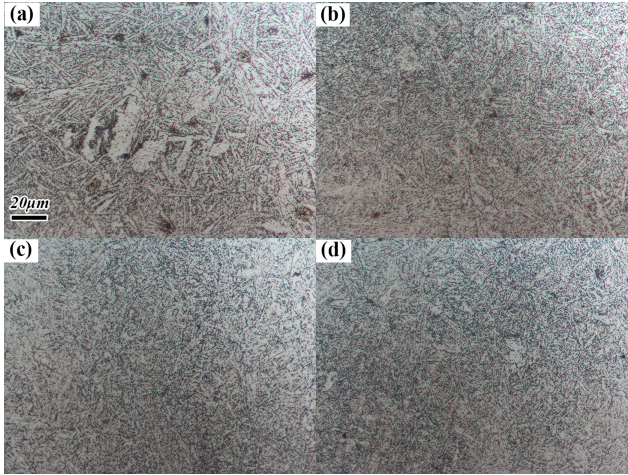
Figure 3. Metallographic observations of the annealed specimens: ( a ) 0RE; ( b ) 0.018RE; ( c ) 0.048RE and ( d ) 0.15RE.